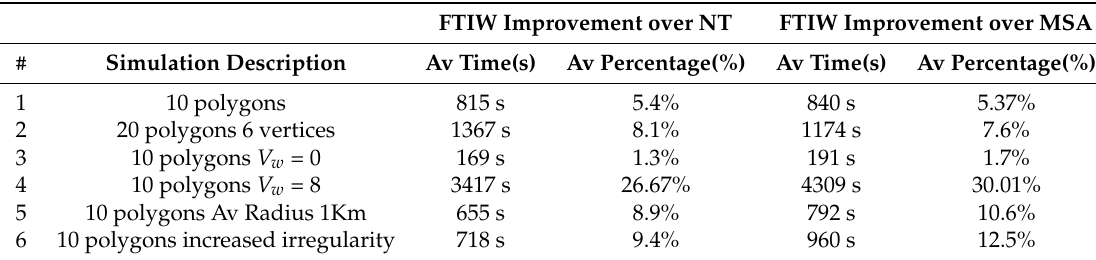
Table 2. Monte Carlo simulation results, 70 random polygons